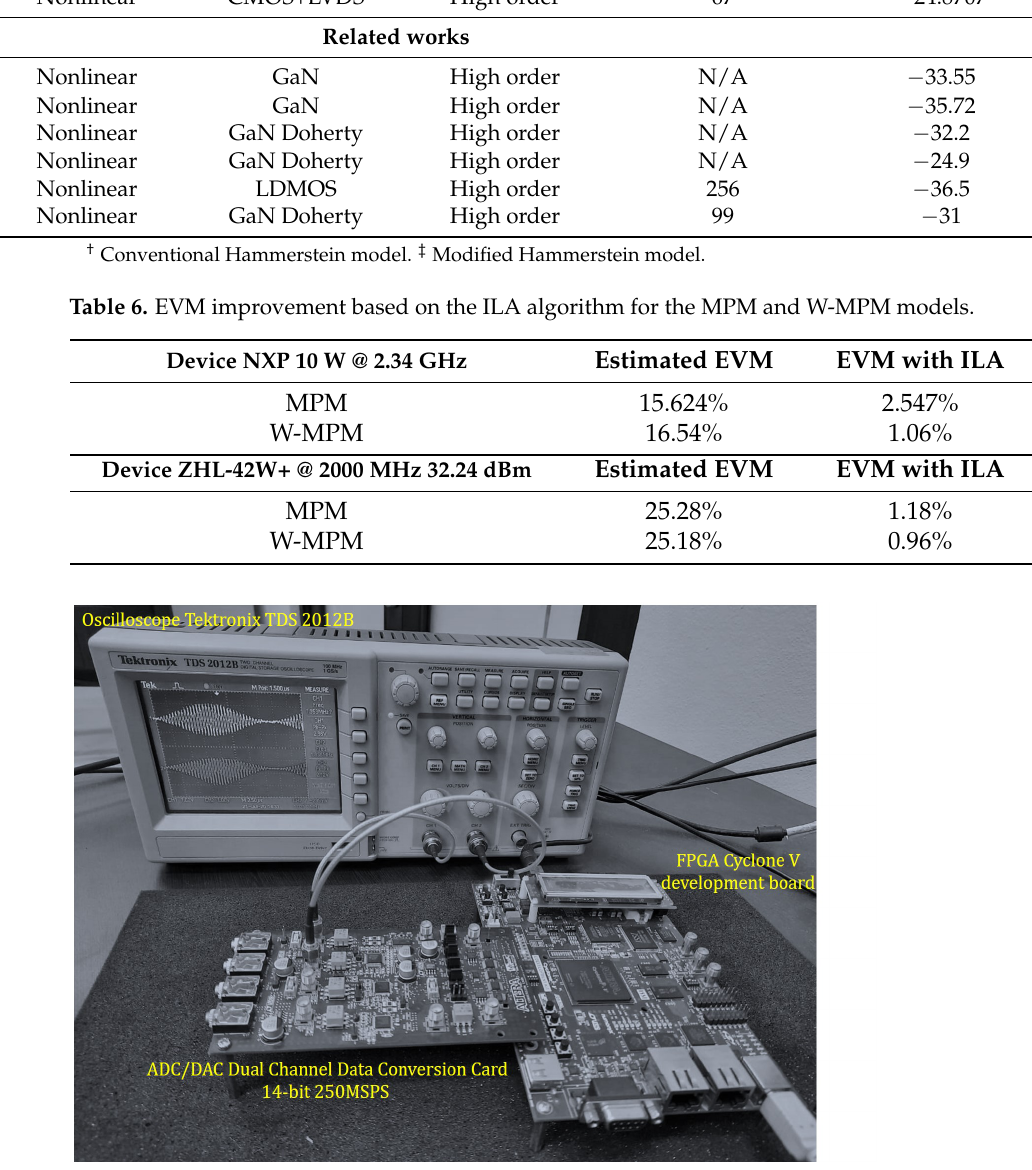
Figure 7. Photograph of setup hardware implementation of the adaptive modeling W-MPM